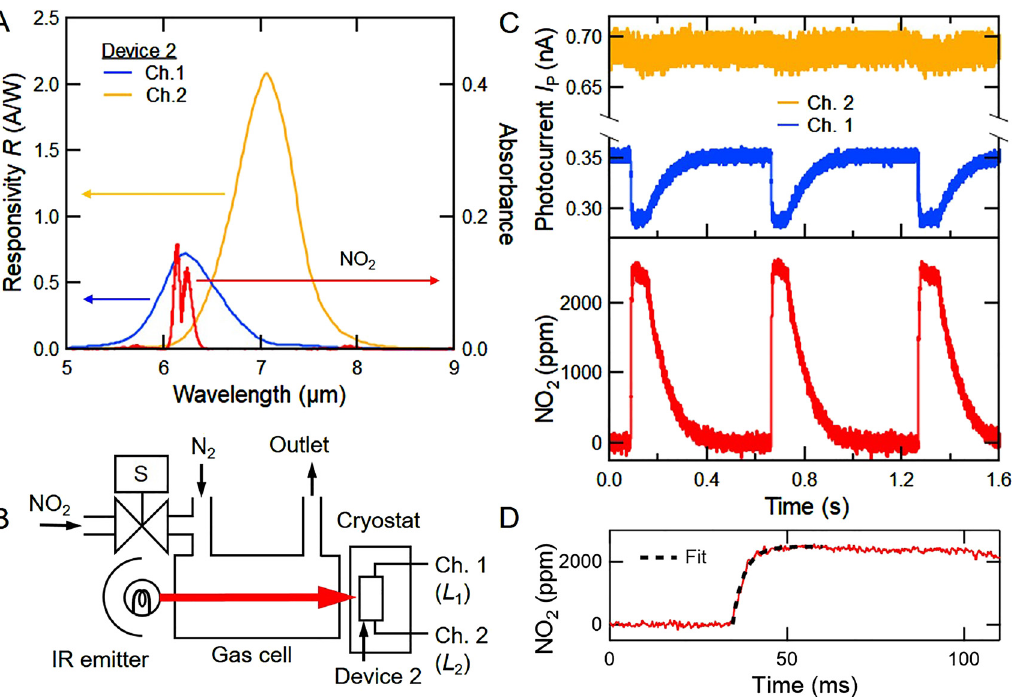
Figure 4: Dual-channel sensing using a dual-band metasurface quantum well infrared photodetector (QWIP) (Device 2). A) Experimentally determined resonance of Ch. 1 ( L 1 = 0.89 μ m) is matched to NO 2 absorption peak at λ = 6.25 μ m. Ch. 2 ( L 2 = 1.07 μ m) is the non-absorbing reference. NO 2 absorbance at 100 ppm-m in 1 atm N 2 at 25 ° C (right axis). B) Experimental setup for fast response NO 2